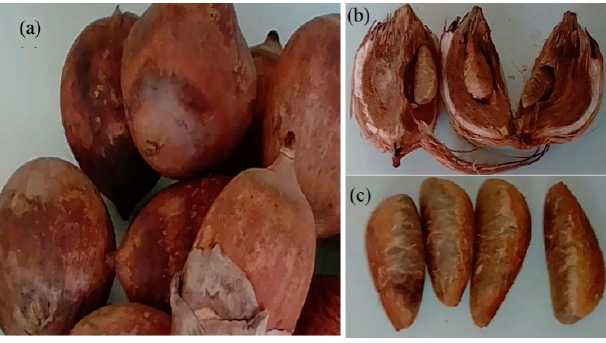
Figure 7. ( a ) Fruit, ( b ) endocarp and ( c ) nut of babassu